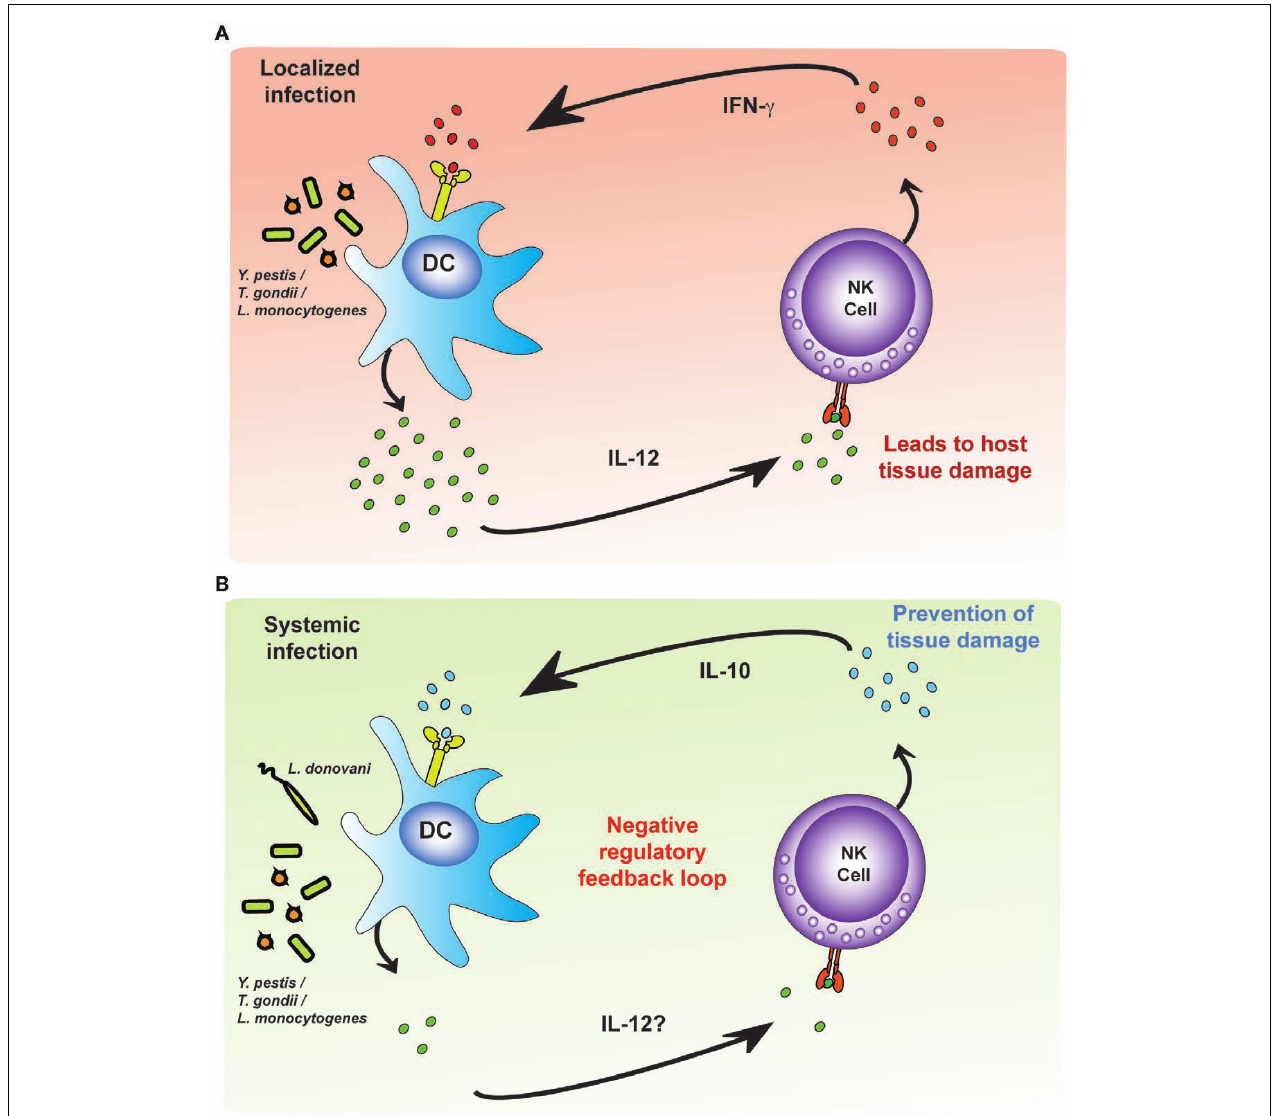
expense of significant tissue damage. (B) During systemic infection, as yet uncharacterized differences in the environmental cues provided by accessory cells (but possibly influenced by the concentration of IL-12) lead to NK cell production of IL-10. NK cell-derived IL-10 limits tissue damage but may also allow the infection to